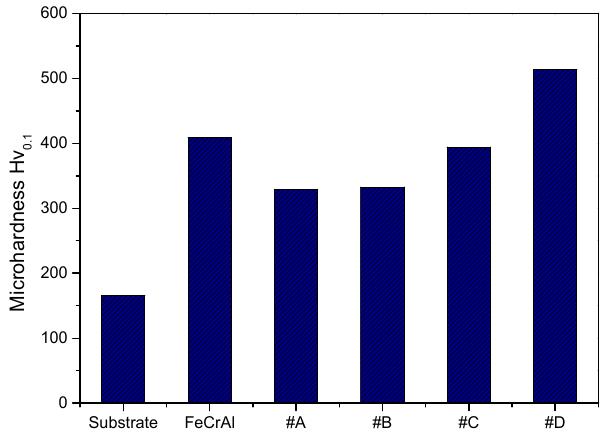
Figure 6. Vickers microhardness of high velocity arc spraying (HVAS) coatings.